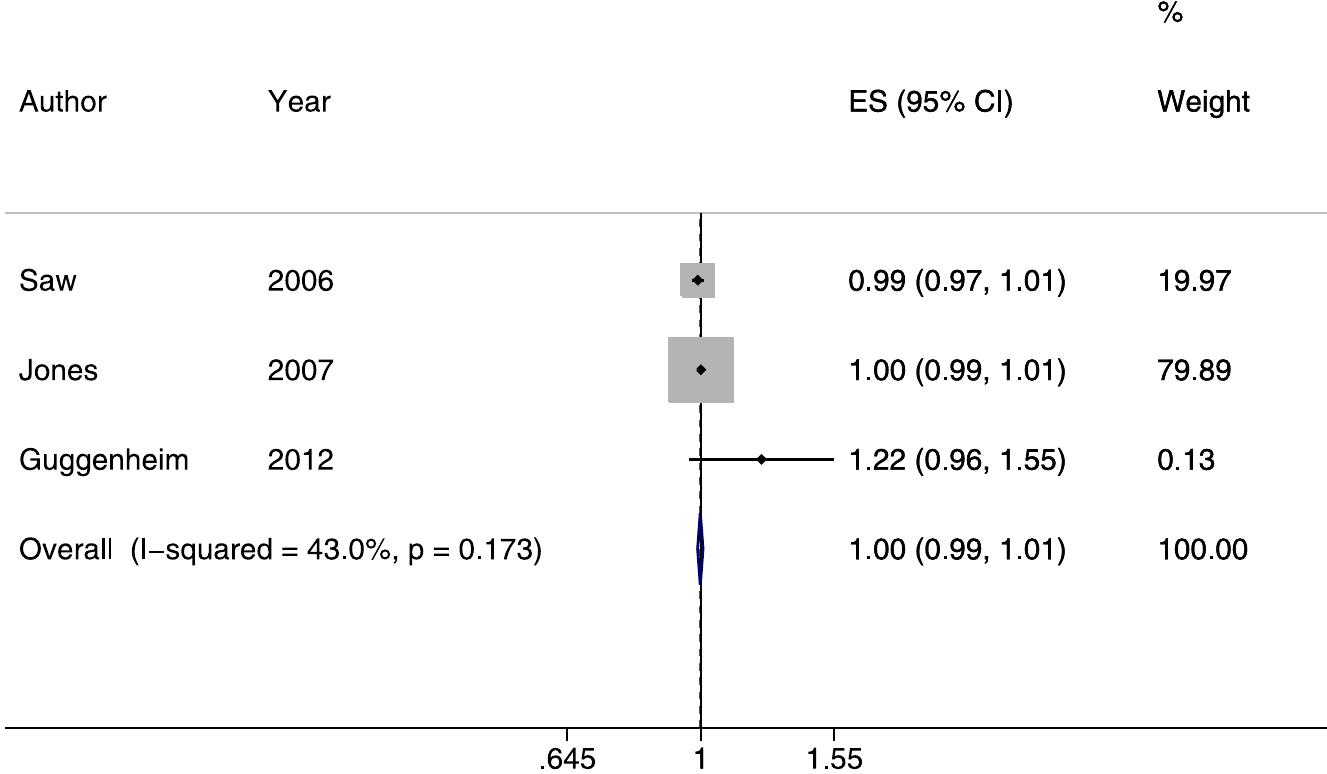
Fig 6. Forest plot of studies reporting an association between near work and the incidence of developing myopia (risk ratio, RR). The incidence of myopia was not increased as children spent more diopter-hours performing near work activities (RR:1.00, 95% CI: 0.99 – 1.01).